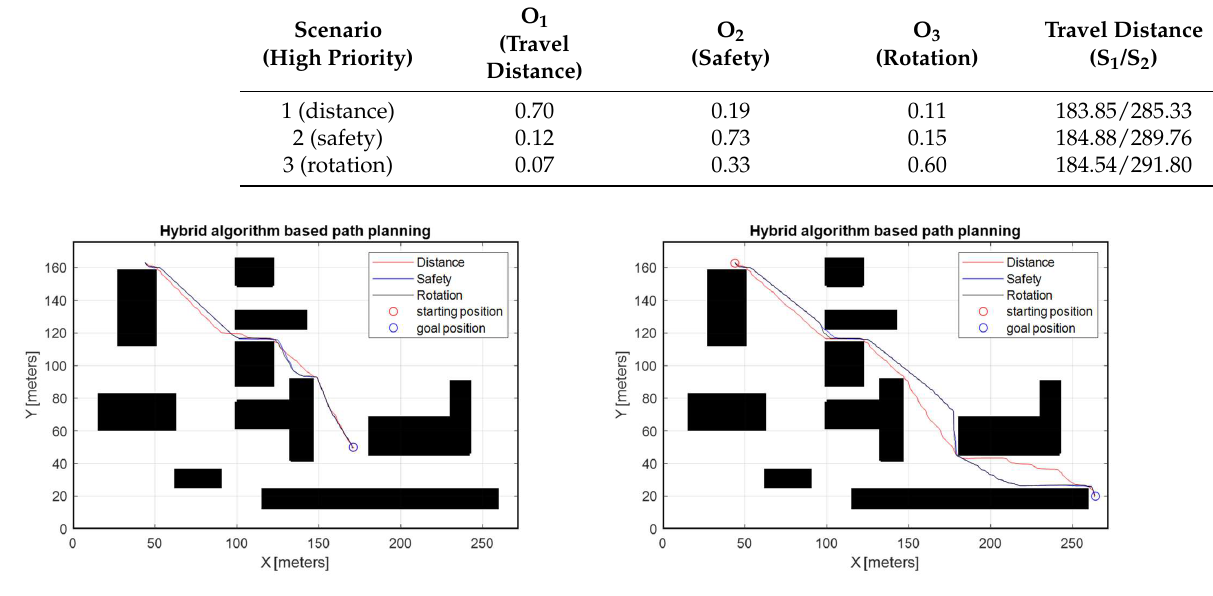
Figure 9. Hybrid algorithm-based path planning.